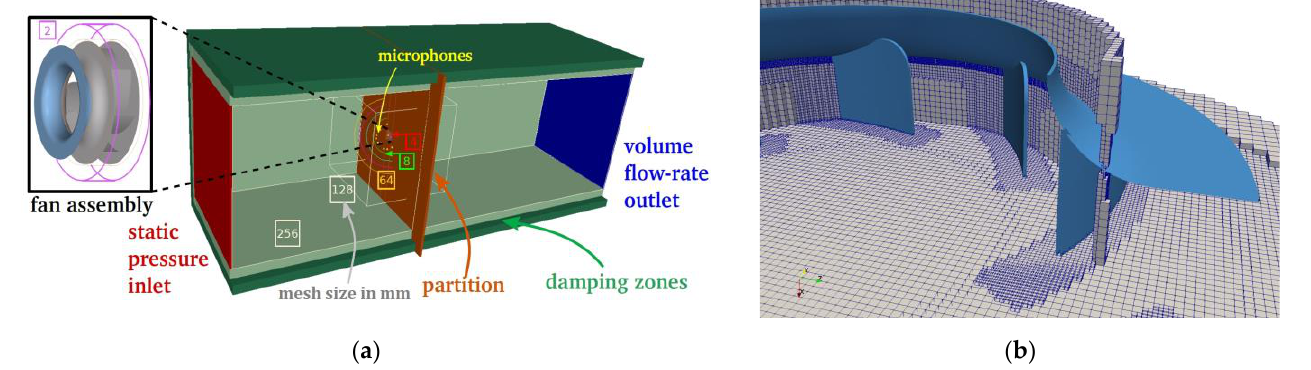
Figure 3. Computational domain and refinement volume definitions: ( a ) numbers in squares provide the mesh size in mm for the outlined refinement volume; ( b ) and mesh resolution around the fan blades.